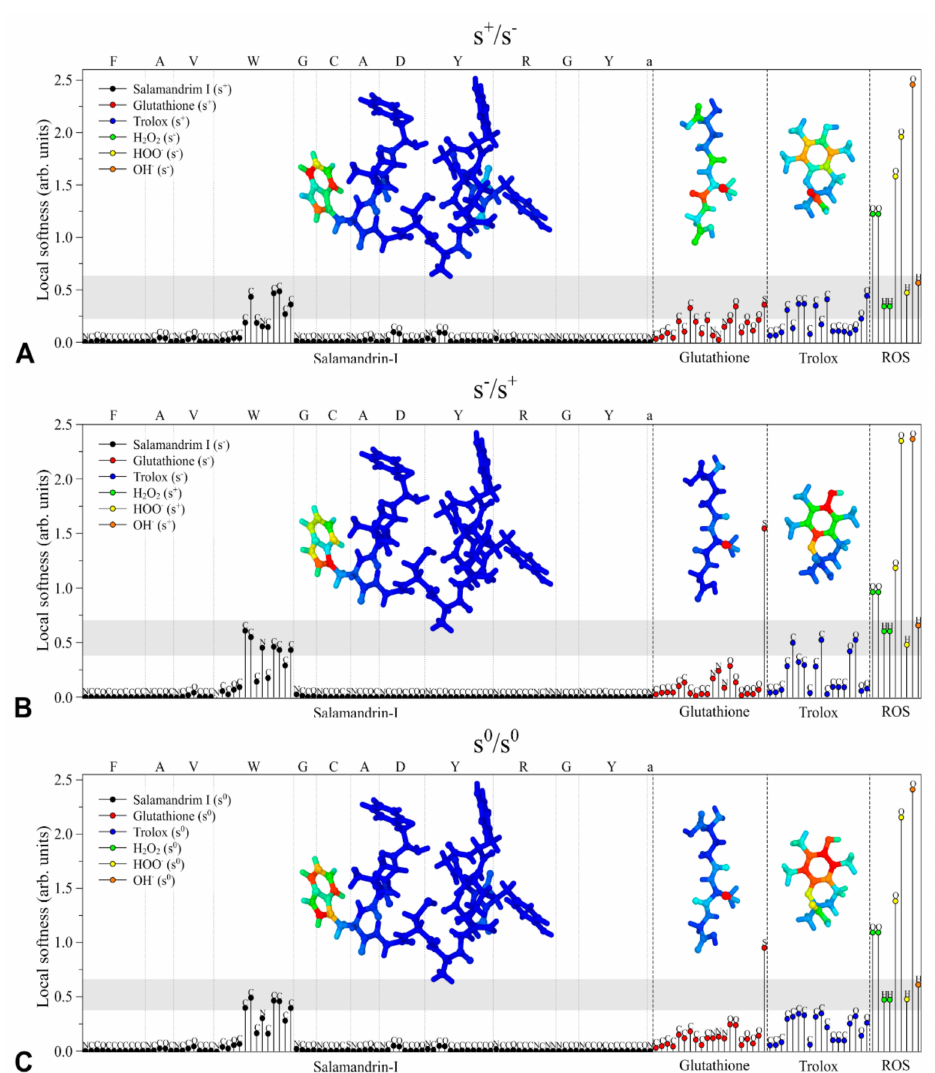
Figure 5. Comparative study of the local chemical softness of salamandrin-I, glutathione, and Trolox in relation to H 2 O 2 , HOO • and OH • . Antioxidant activities: ( A ) antioxidants (AOX) as electrophiles (s + / s − ). ( B ) AOX as nucleophiles (s − / s + ), and ( C ) AOX as free-radicals scavengers (s 0 / s 0 ). Inset: condensed-to-atom Fukui indexes (CAFI)—red to blue colors define reactive and non-reactive